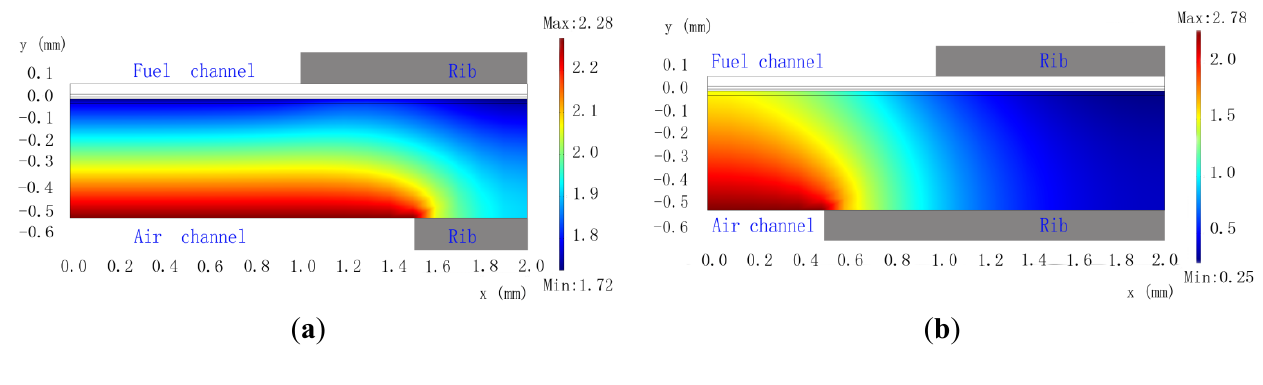
in ( a ) Cell-C and ( b ) 2